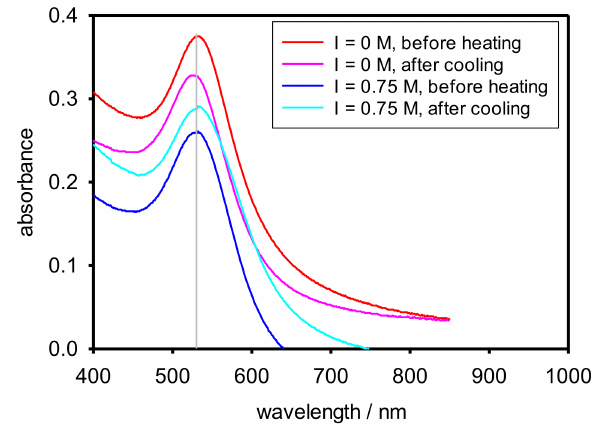
Figure 9. UV-vis spectra of the nanocomposite (AuNPs + Cop-48/6) at 25 ◦ C in varying NaCl concentrations before heating and after